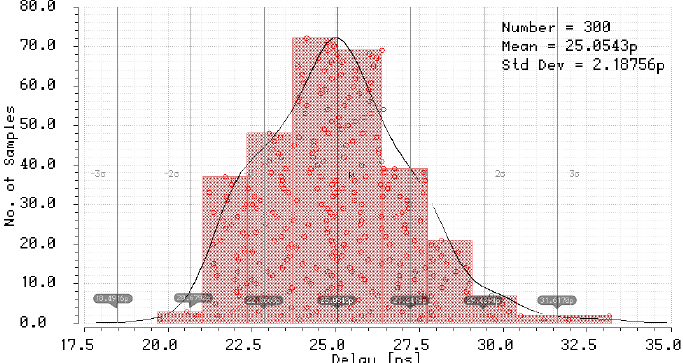
Figure 40. Simulation results of mismatch for unit delay element (pair of inverters) for 180 nm CMOS process.